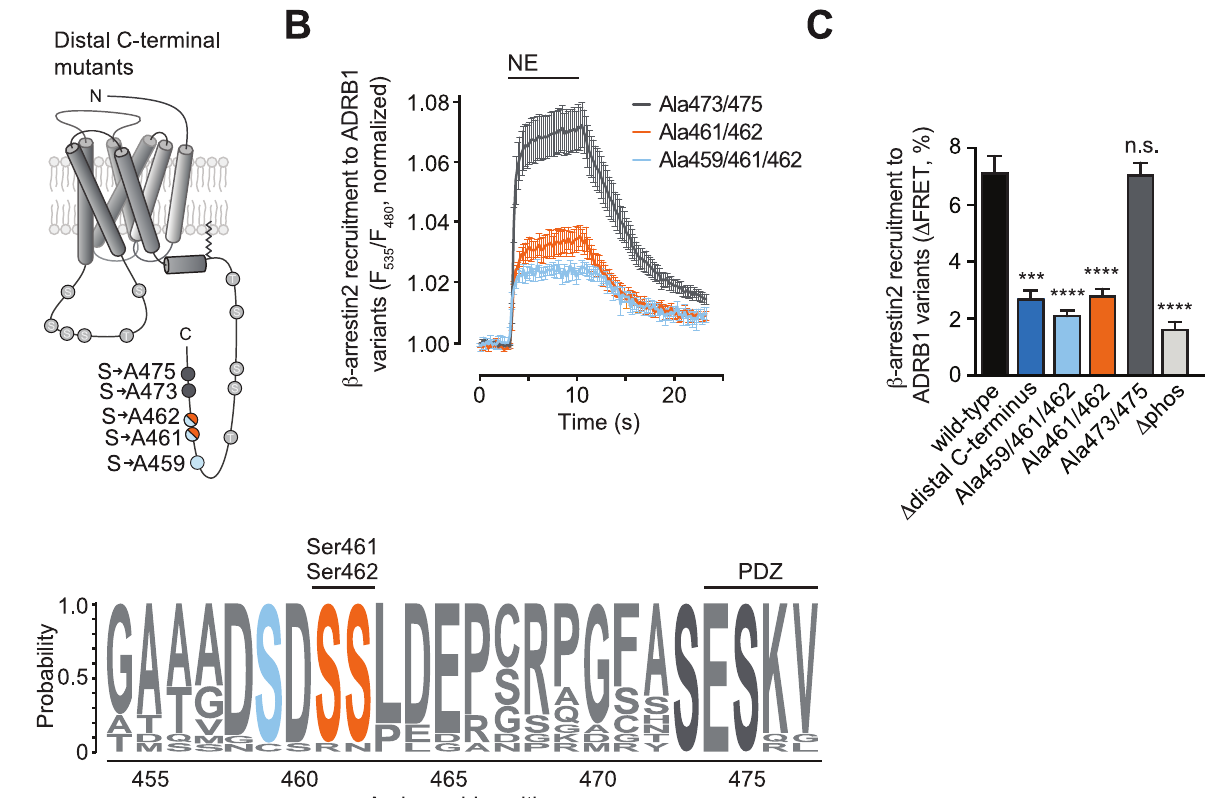
Fig 3. Phosphorylation at Ser461/Ser462 in the distal C-terminus determines arrestin binding. ( A ) Schematic of the humanADRB1 highlightingthe phosphosites mutated in the distal C-terminus: ADRB1(Ala459/461/462) (light blue), ADRB1(Ala461/462) (orange)and ADRB1 (Ala473/475) (dark grey). ( B ) AveragedFRET tracings comparing ADRB1(Ala459/461/462), ADRB1(Ala461/462)and ADRB1 (Ala473/475). Data are means ± SEM of n (cid:21) 6 representative tracings. ( C ) Quantificationof NE-induced changesof receptor-arrestin FRET obtainedfor the ADRB1 variants depictedin (B). Data are means+SEM of n (cid:21) 9 cells. *** p (cid:20) 0.001 vs. wild-typeand n.s. = not significant.( D ) Conservation of serine 459 (light blue), serine 461 and serine 462 (orange)amongtwelve species.